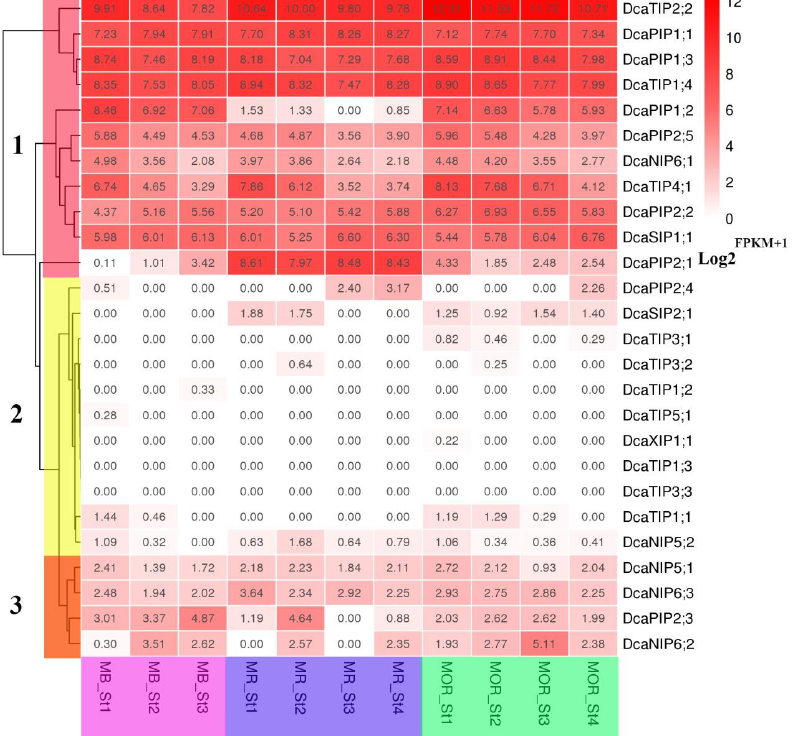
Figure 5. Expression profiles of DcaAQP genes during flower opening stages. MB, MR and MOR represent three carnation cultivars. St1 means stage1, St2 means stage2, St3 means stage3, St4 means stage4. A heat-map shows the hierarchical clustering of relative expression of all DcaAQP genes during flower opening stages analyzed. The vertical color scale at right of the image represents log 2FPKM+1 : the expression level were displayed by the depth of red.